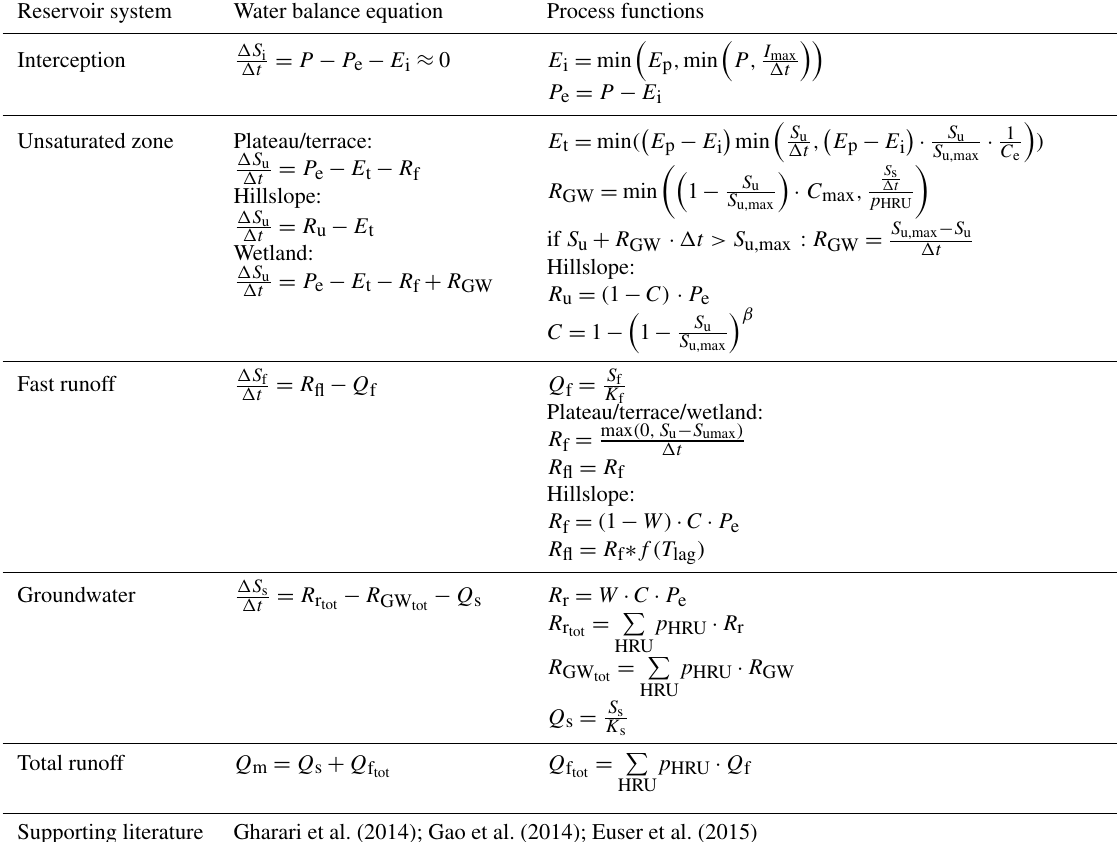
Table 3. Equations applied in the hydrological model. Fluxes (mmd − 1 ): precipitation ( P ), effective precipitation ( P e ), potential evaporation ( E p ), interception evaporation ( E i ), plant transpiration ( E t ), infiltration into the unsaturated zone ( R u ), drainage to fast runoff component ( R f ), delayed fast runoff ( R fl ), groundwater recharge ( R r for each relevant HRU and R r,tot combining all relevant HRUs), upwelling ground- water ( R GW for each relevant HRU and R GW,tot combining all relevant HRUs), fast runoff ( Q f for each HRU and Q f,tot combining all HRUs), groundwater/slow runoff ( Q s ), total runoff ( Q m ). Storages (mm): storage in interception reservoir ( S i ), storage in unsaturated root zone ( S u ), storage in groundwater/slow reservoir ( S s ), storage in fast reservoir ( S f ). Parameters: interception capacity ( I max ) (mm), maxi- mum upwelling groundwater ( C max ) (mmd − 1 ), maximum root zone storage capacity ( S umax ) (mm), splitter ( W ) (–), shape parameter ( β ) (–), transpiration coefficient ( C e ) (–), time lag ( T lag ) (d), reservoir timescales (d) of fast ( K f ) and slow ( K s ) reservoirs, areal weights ( p HRU ) (–), time step ( (cid:49)t ) (d). Model parameters are shown in bold letters in the table below. The equations were applied to each